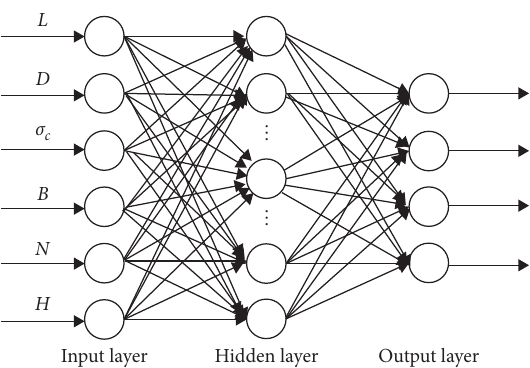
Figure 2: Structure design Figure of BP artificial neural network. Table 4: Testing